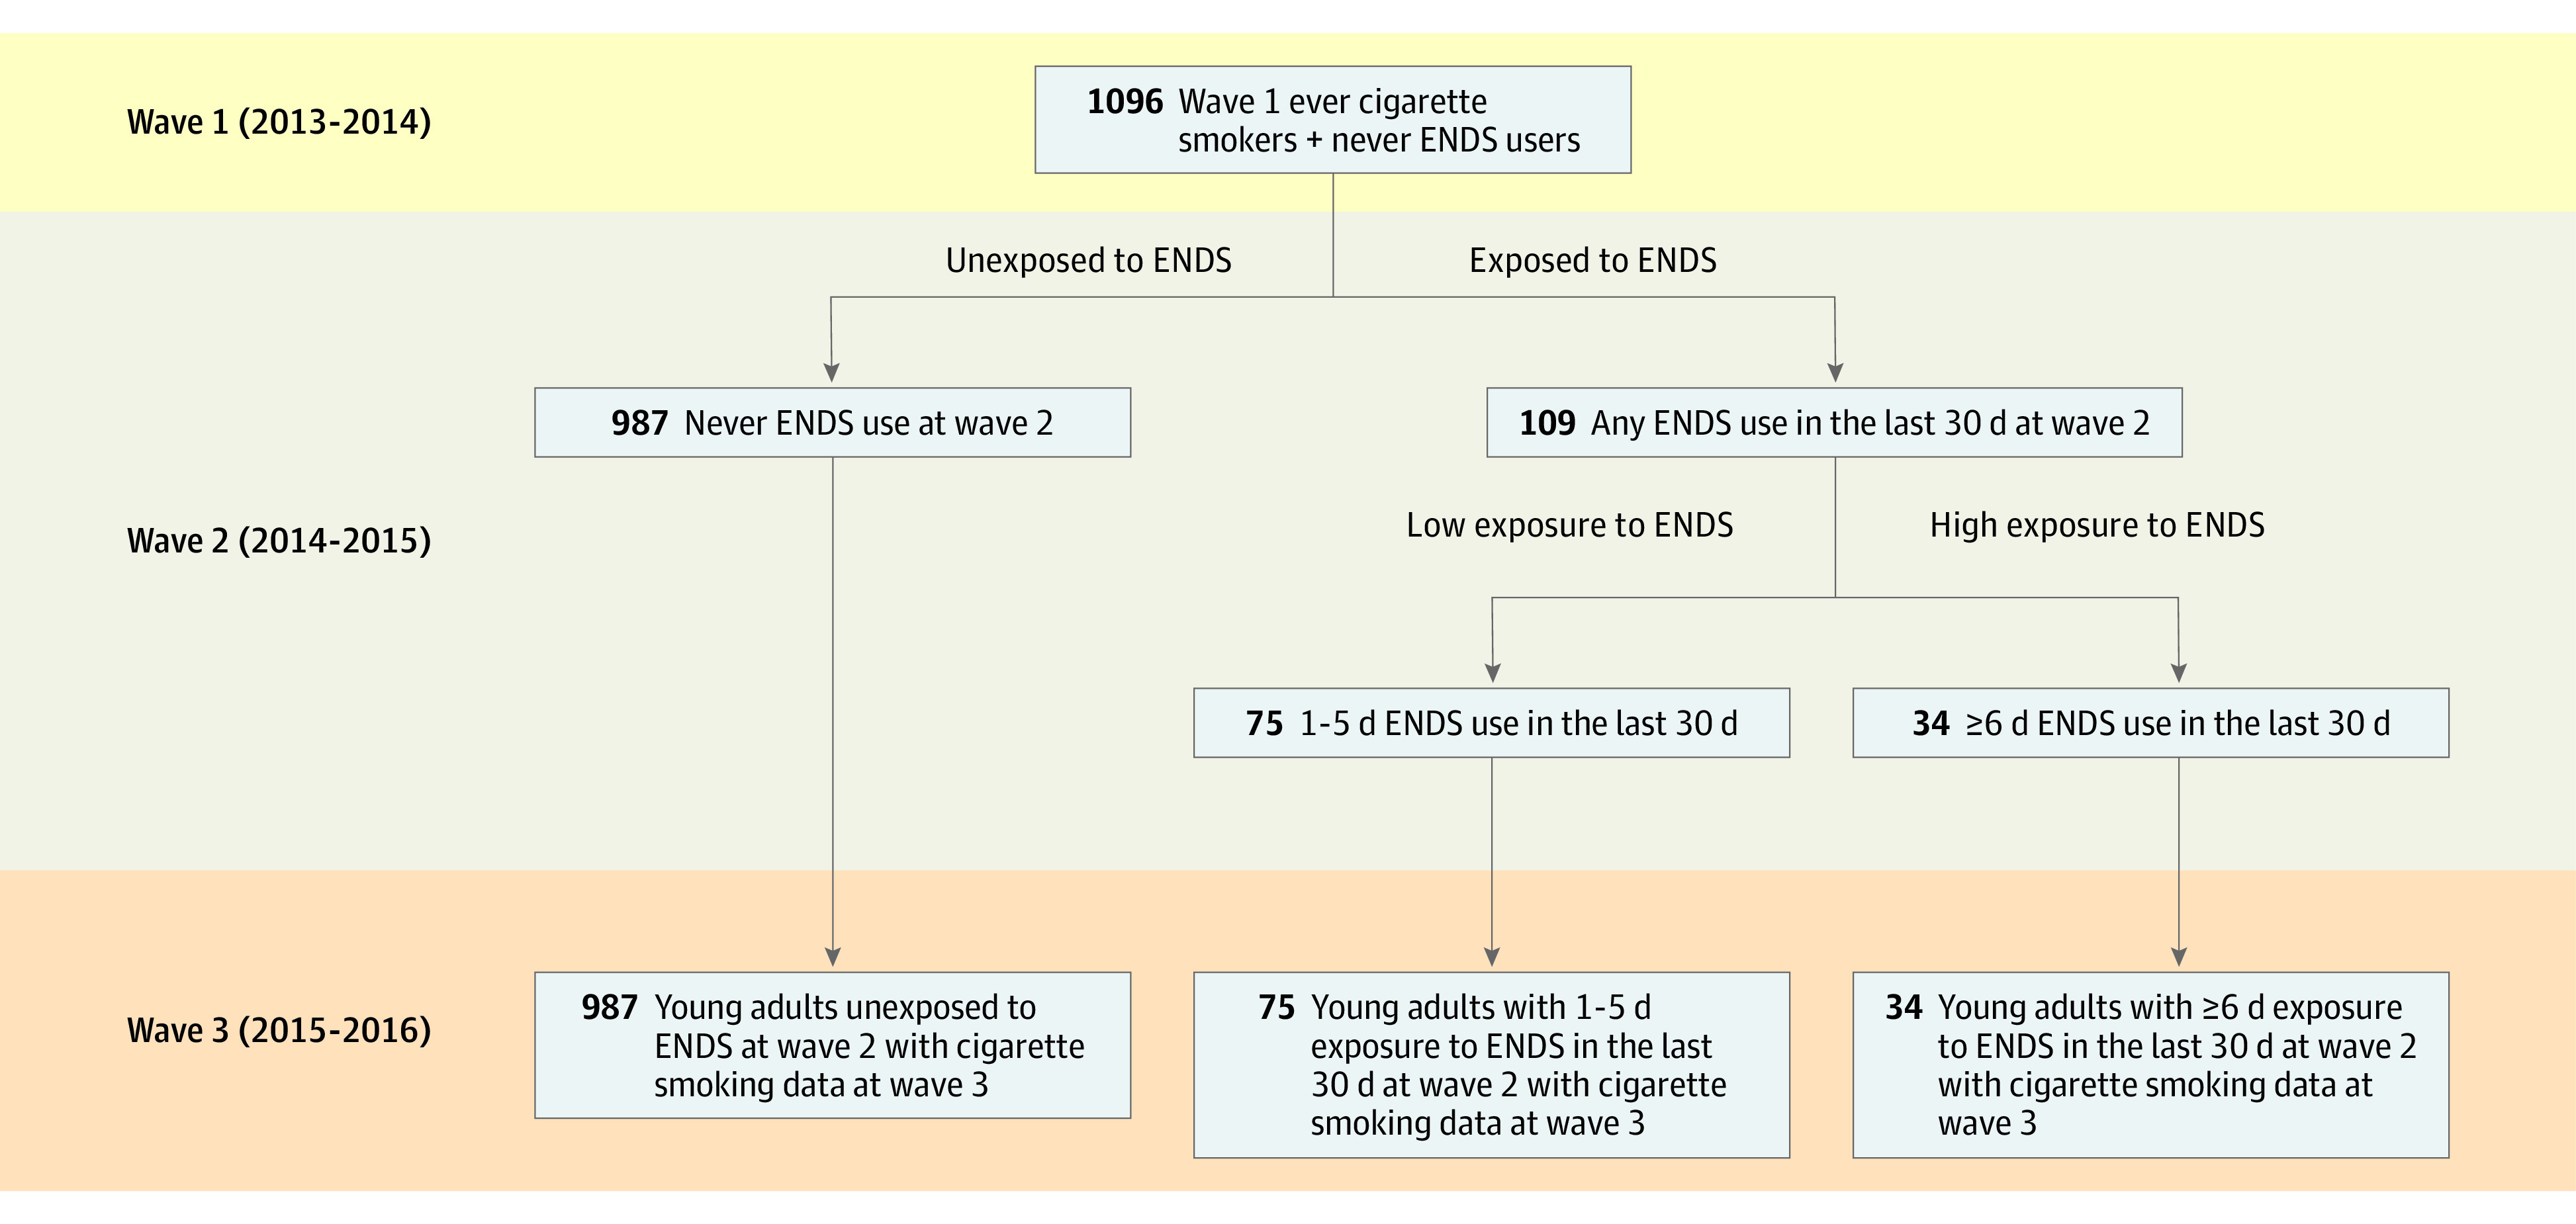
Description of Sample Size and Exposure Status for the Young Adult Analytic Sample From the Population Assessment of Tobacco Health Study Wave 1 to Wave 3.ENDS indicates electronic nicotine delivery system.